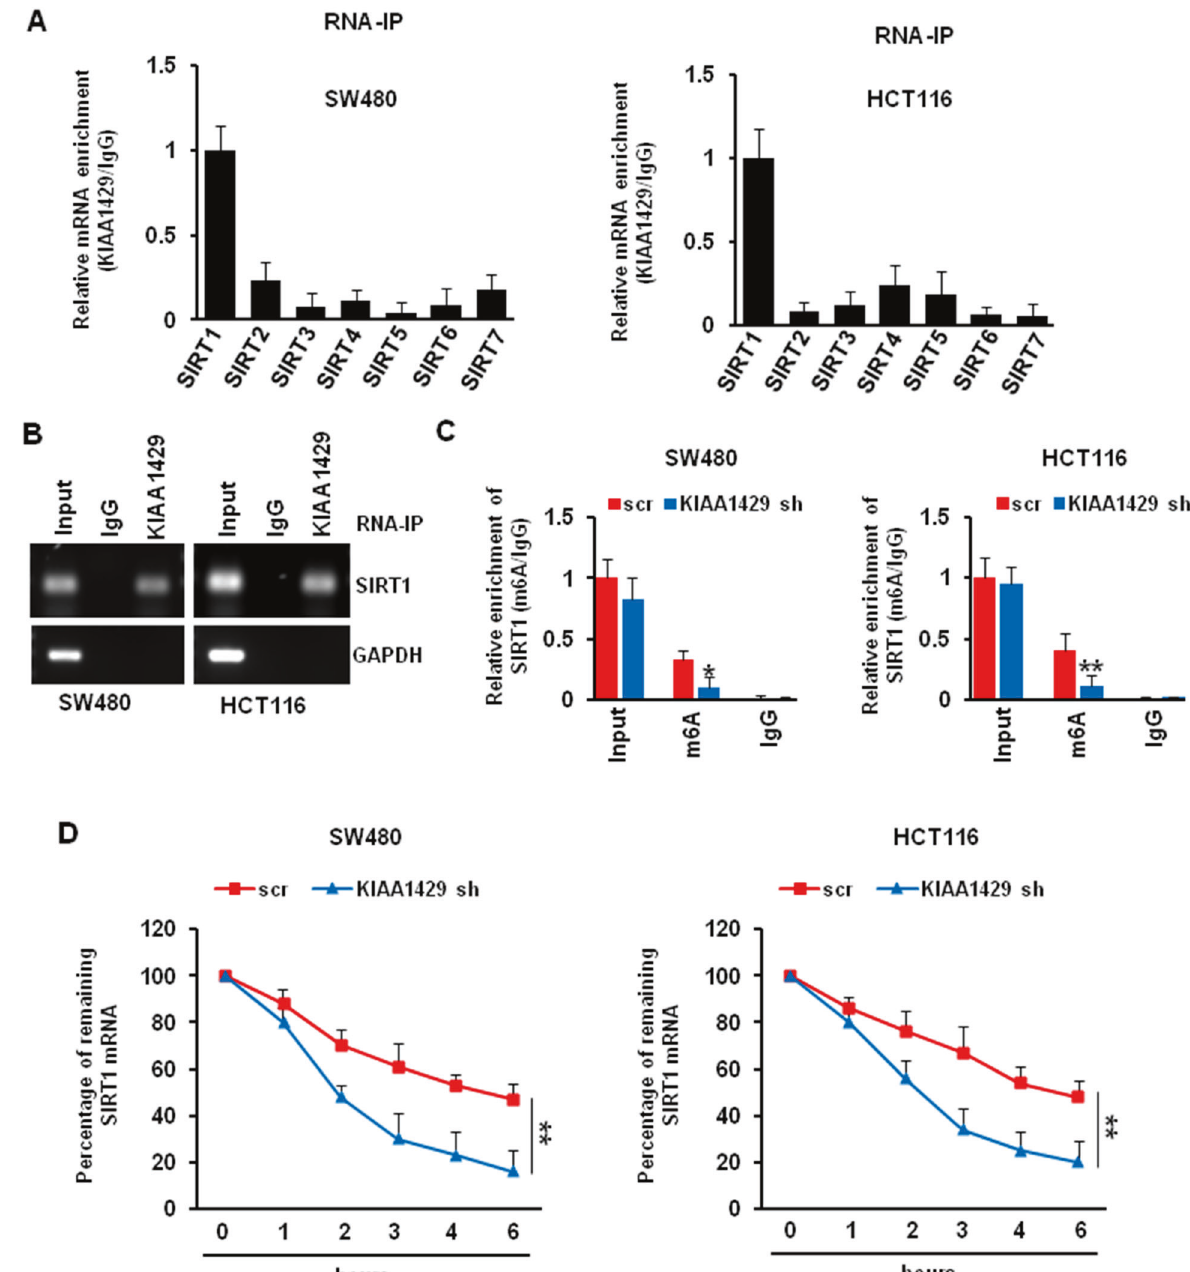
Fig. 6 Effect of KIAA1429 on regulating SIRT1 mRNA stability. A SW480 and HCT116 cell lysates were immunoprecipitated with KIAA1429 antibody followed by QRT-PCR measuring transcript levels of all indicated targets. B PCR measured transcript levels of SIRT1 and GAPDH within KIAA1429 or IgG immunocomplexes in SW480 and HCT116 cell lysates. C SW480 and HCT116 cells were infected with scr and KIAA1429 shRNA, the cell lysates were immunoprecipitated with m 6 A antibody followed by QRT-PCR measuring transcript levels of SIRT1. * P < 0.05, ** P < 0.01. D SW480 and HCT116 cells were infected with scr and KIAA1429 shRNA for 72 h, then treated with 8 μ g/ml Act D for 0, 1, 2, 4, 6, 8 h. The stability of SIRT1 mRNA was described in Materials and Methods. ** P <